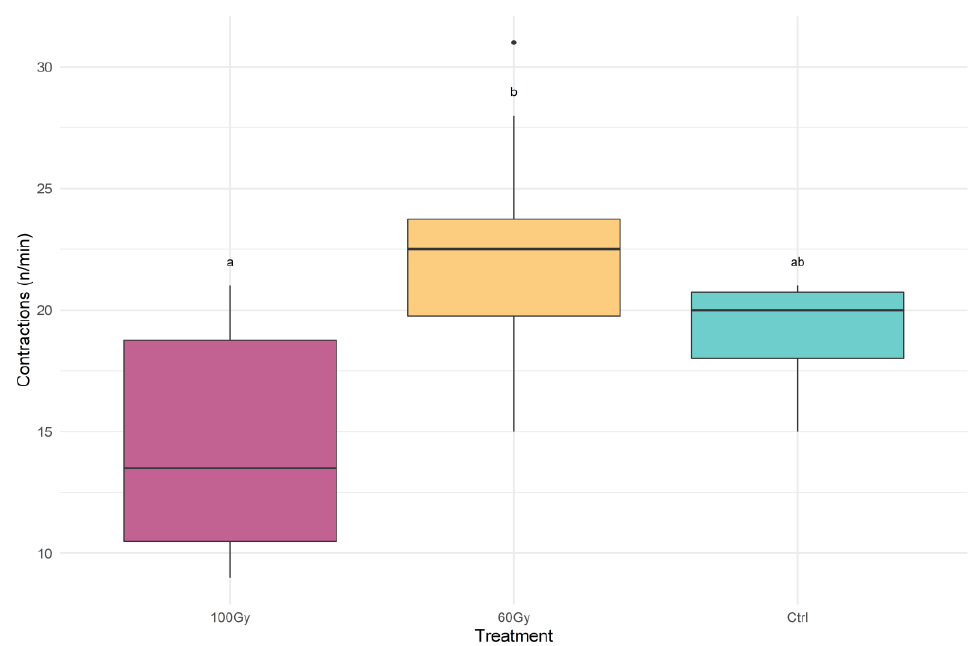
Figure 5. Box plot with the rate of contractions per minute that occurred during mating for each treatment. The treatments indicated with di ff erent le tt ers show signi fi cant di ff erences (one-way ANOVA at p < 0.01). The box plots represent the interquartile range, with a horizontal bar as the median. The bo tt om whisker and the upper whisker represent the minimum and maximum values, respectively. The dots show the outliers.